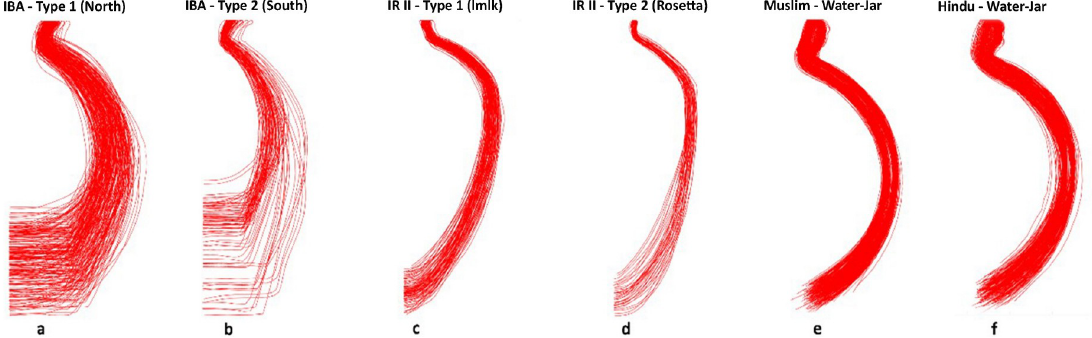
Fig 13. Overlapping of the jar’s profiles, from right to left: IBA jars, north type 1 (a); IBA jars, south type 2 (b); IR type 1 lmlk jars (c); IR type 2 Rosetta jars (d); Muslim water-jars (e); Hindu water-jars (f).